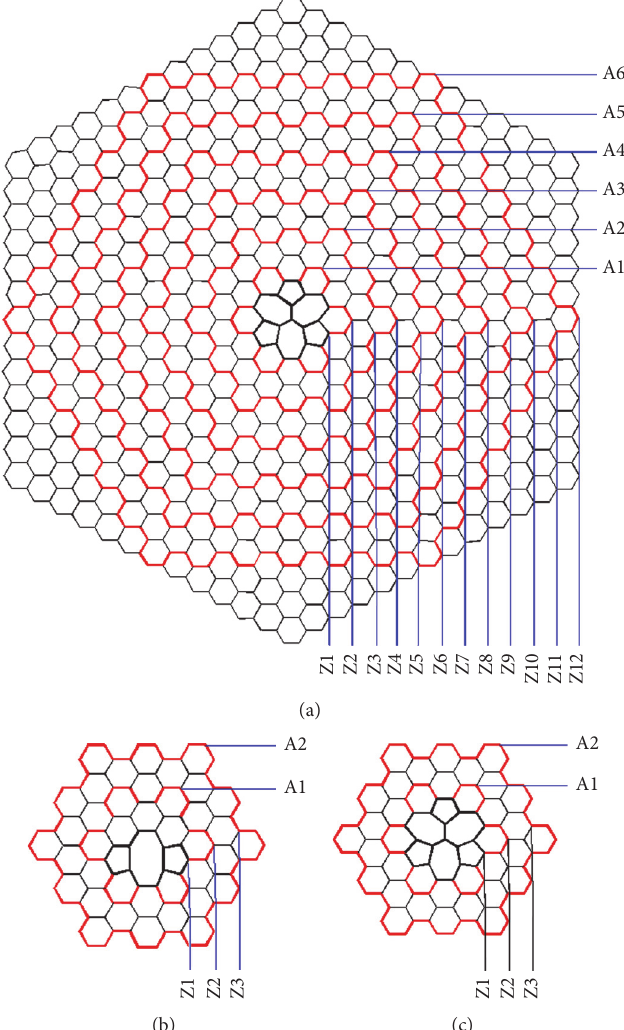
Figure 1: (a) The model structures of the two types divacancies, black bond stands for the zigzag-edge hexagonal graphene flakes and red bonds stand for the armchair ones. (b) Example for the small sizes of the zigzag (Z1, Z2, Z3) and armchair (A1, A2) hexagonal flakes with 585 defects in the center. (c) Example for the small sizes of the zigzag and armchair hexagonal flakes with 555777 defects in the